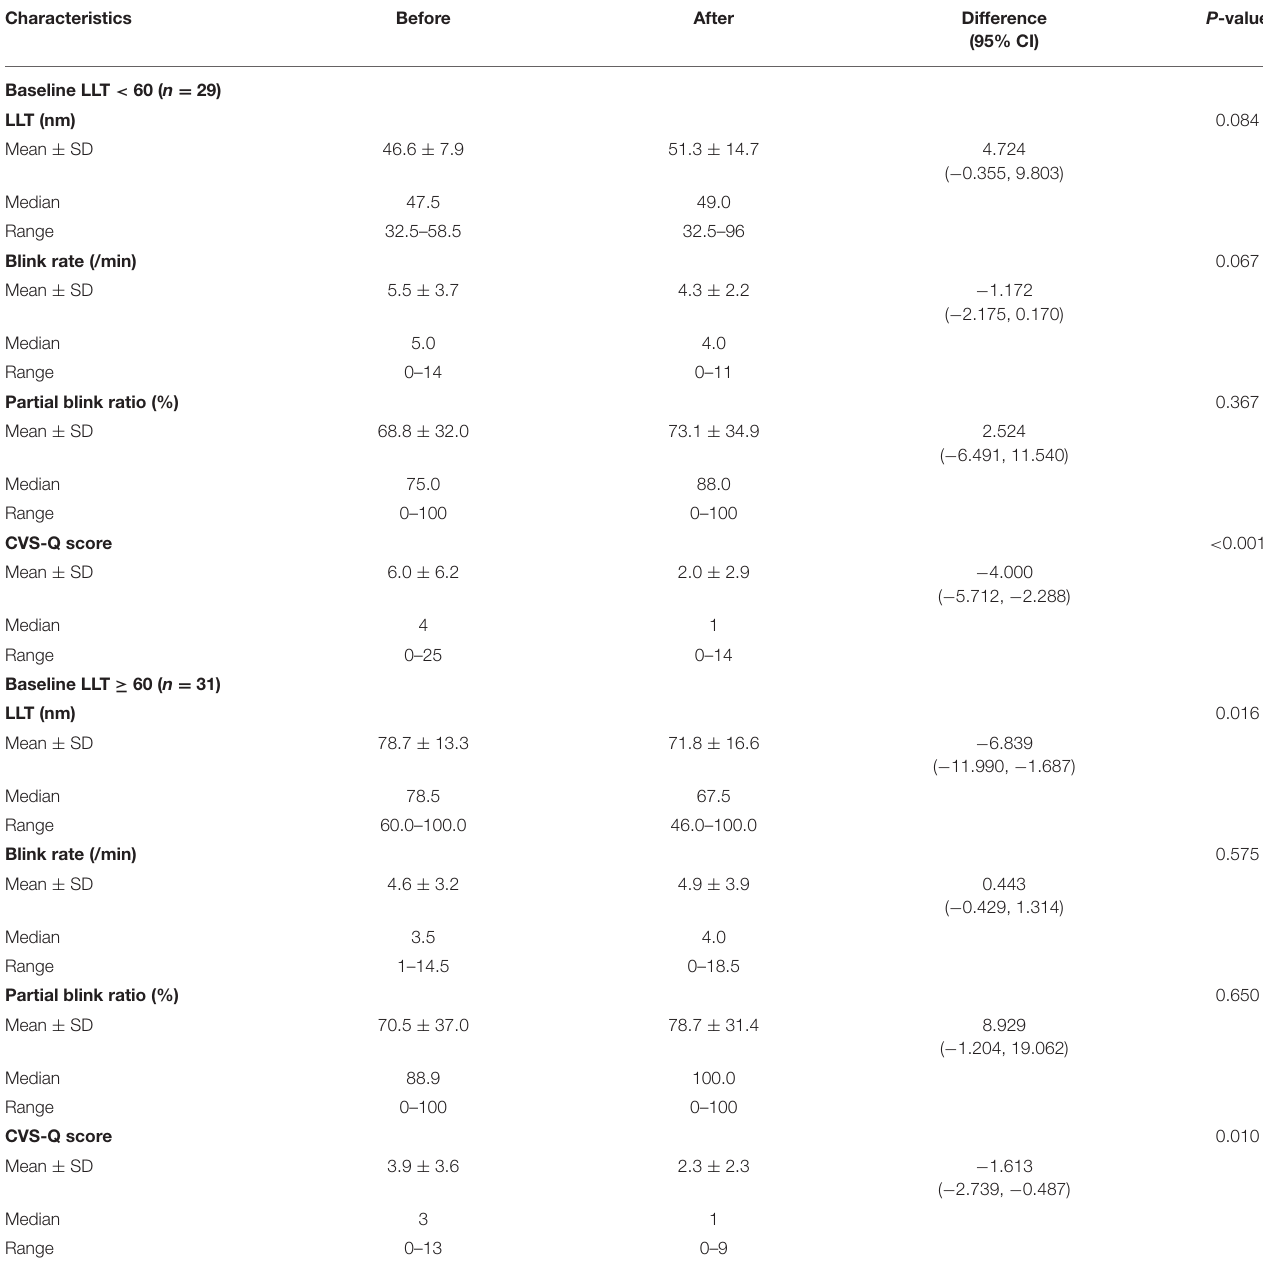
TABLE 4 | Changes after watching an LED display based on the participants’ baseline lipid layer thickness. Characteristics Before After Difference